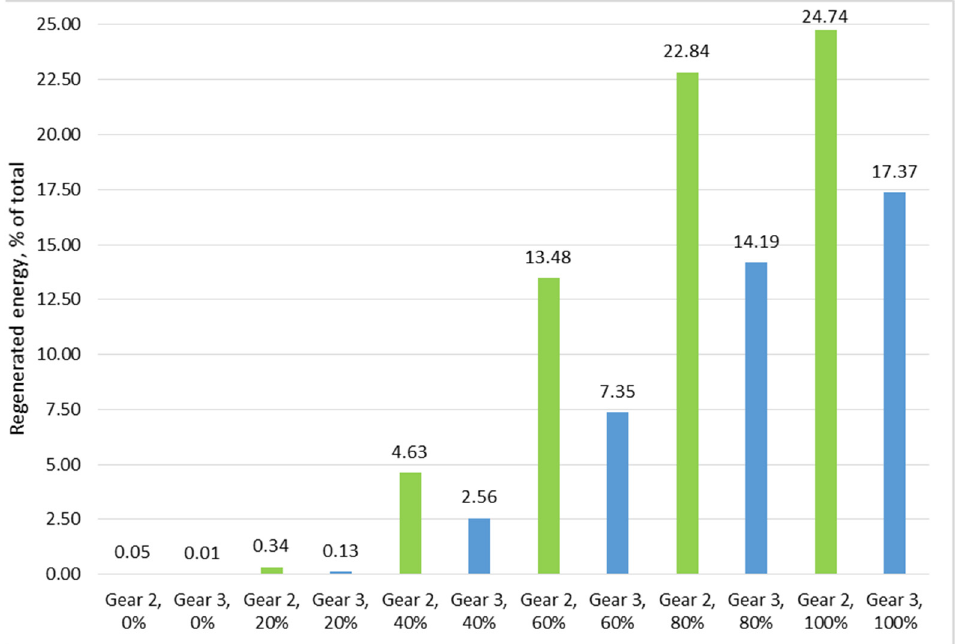
Figure 8. Regenerated energy as a % of total energy when driving in 2nd and 3rd gears at different regenerative braking settings.